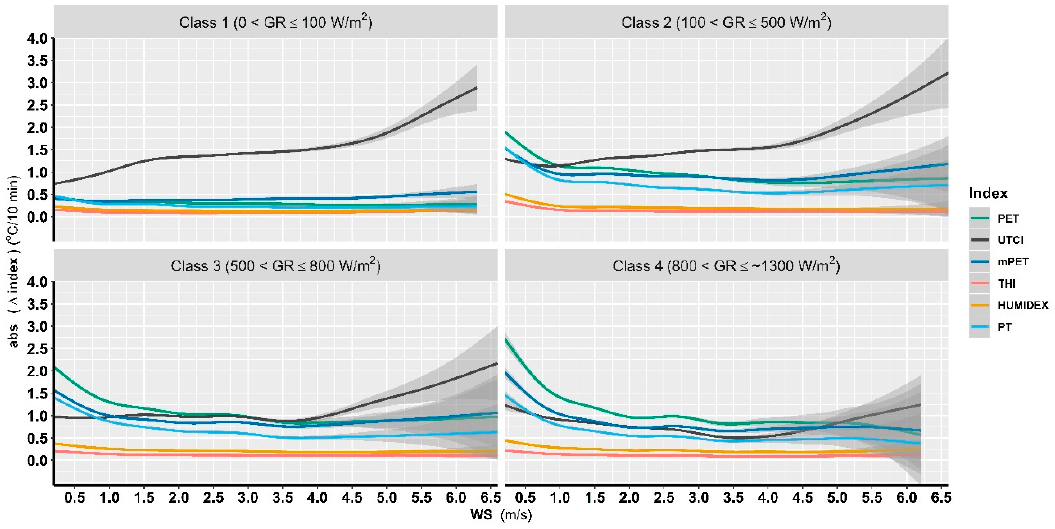
Figure 5. The sensitivity of the indices to Wind Speed (WS) variation under di ff erent Global Radiation (GR) conditions. Table 5. Descriptive statistics of the indices’ sensitivity to Wind Speed (WS) under di ff erent Global Radiation (GR) conditions. THI (Thermohygrometric Index), HUM (HUMIDEX), UTCI (Universal Thermal Climate Index), PET (Physiologically Equivalent Temperature), mPET (modified PET), PT (Perceived Temperature). THI